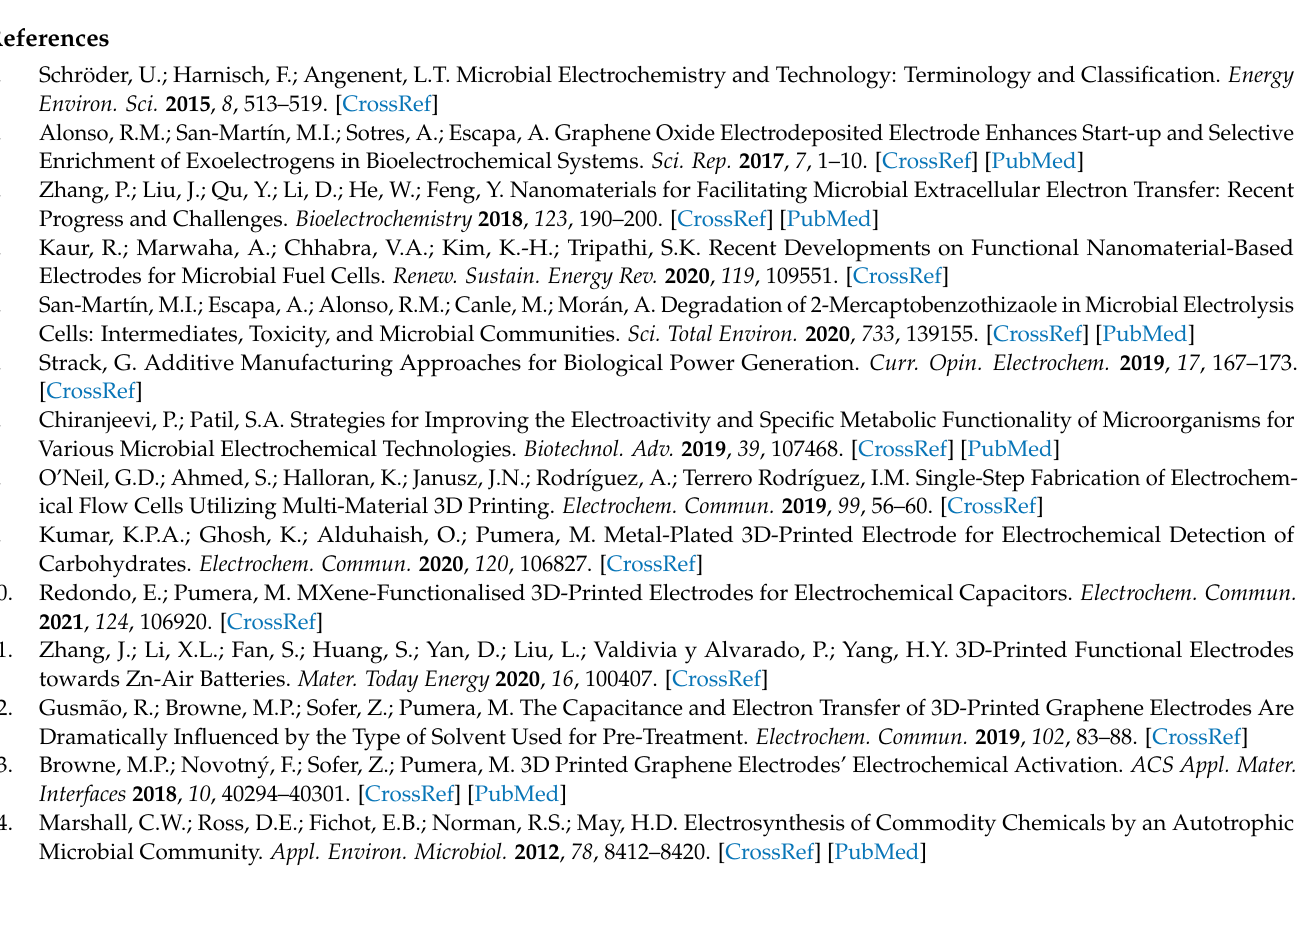
Table S1: Fitted parameters to EC 1 (DMF and acetone electrodes); Table S2: Fitted parameters to EC 2 (control and electrochemical-treated electrodes); Figure S2. Equivalent circuits for abiotic